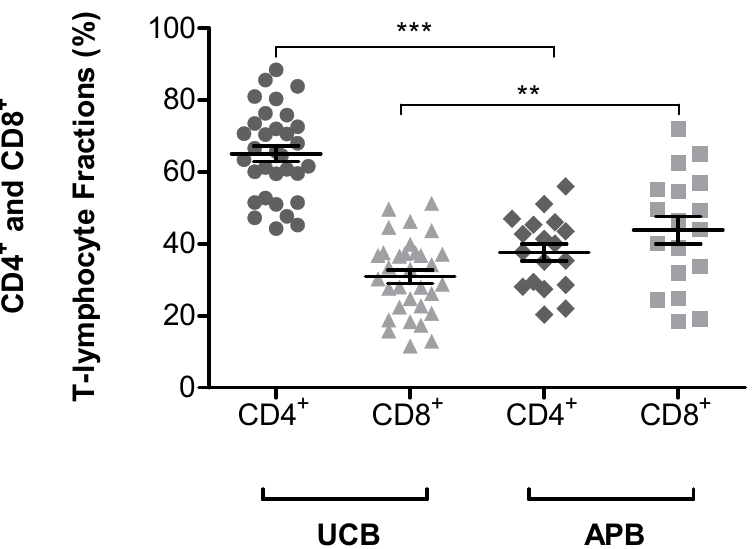
Figure 4. This graph shows the mean percentage of CD4 and CD8 T-lymphocyte subsets in UCB ( n = 32) and APB ( n = 18) samples. A significant difference is noted between CD4 + (*** p < 0.001) and CD8 + (** p < 0.01) fraction when comparing UCB and APB. Error bars represent the standard error of mean (SEM) of the different donors. Table 2. Mean expression (%) of CD45RA and CD45RO on CD4 and CD8 T-lymphocyte subsets in UCB and APB samples validates previous results. The percentage range is given in parentheses. T Newborns Subpopulation